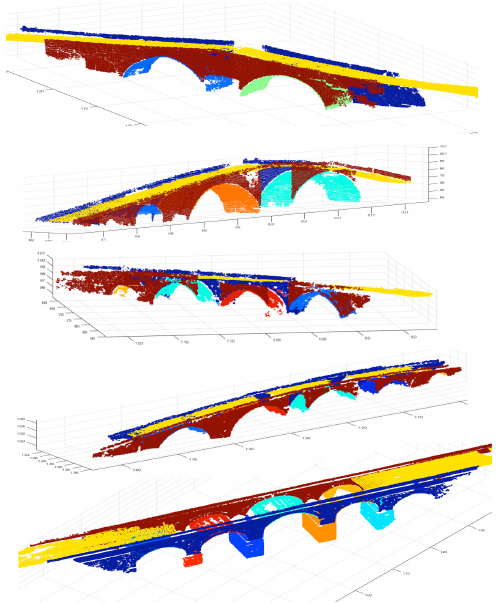
Figure 7. Results of segmentation of Spanish masonry arch bridges, from top to bottom: Allariz, Carracedo, Traba, Cernadela and